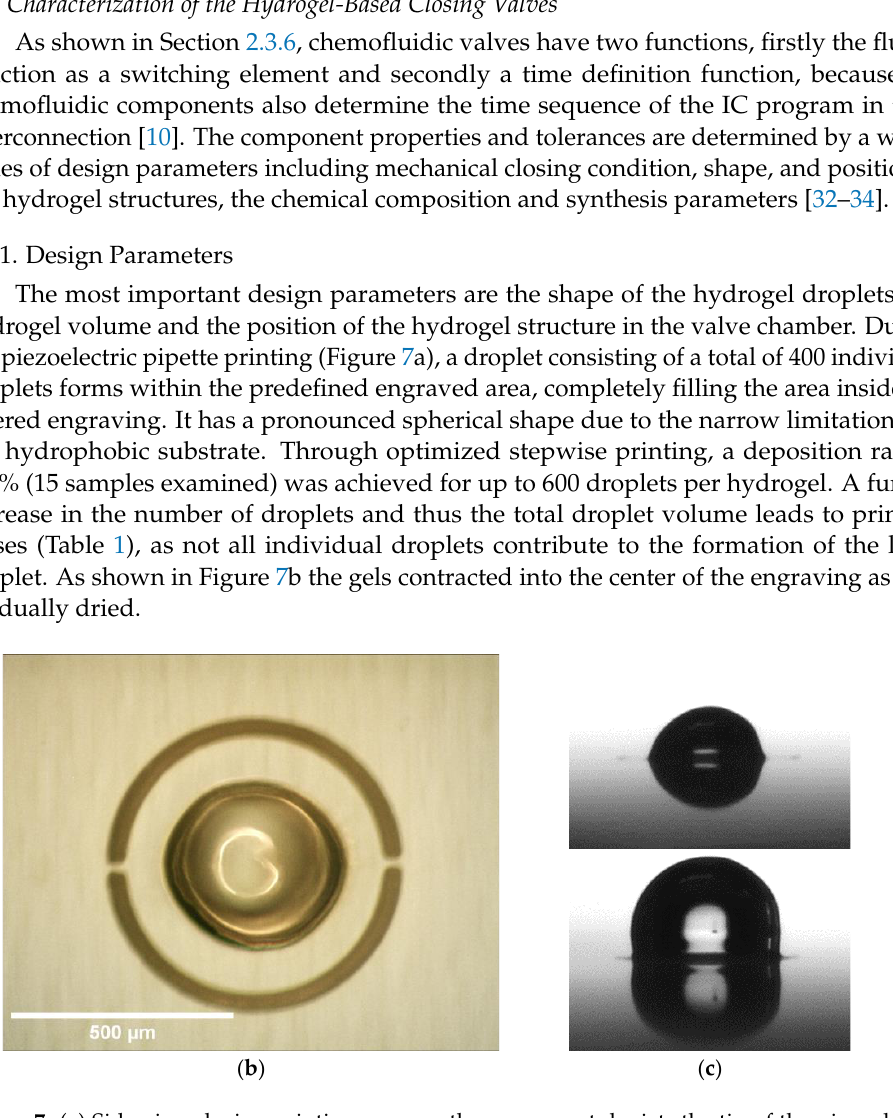
Figure 7. ( a ) Side view during printing process, the upper part depicts the tip of the piezoelectric pipette and underneath it the deposited hydrogel prepolymer solution (400 droplets with a volume around 450 pl per drop) inside the circular engraving on a PMMA substrate. ( b ) Top view of a printed hydrogel (60 s UV exposure time, 400 droplets, ca. 450 pl per drop) after drying, positioned in 600 µm diameter (d E ) engraving. ( c ) Side views of a dry hydrogel ( top ) and of a swollen hydrogel ( bottom ), with the same synthesis parameters as in ( b ). Table 1. Yield of good hydrogels depending on the number of droplets (450 pl per drop) for 600 µ m engraving (number of good hydrogels divided by 15 (total sample size for each number of droplets)). A yield of 100% means that all printed hydrogels can be used as closing valves for further